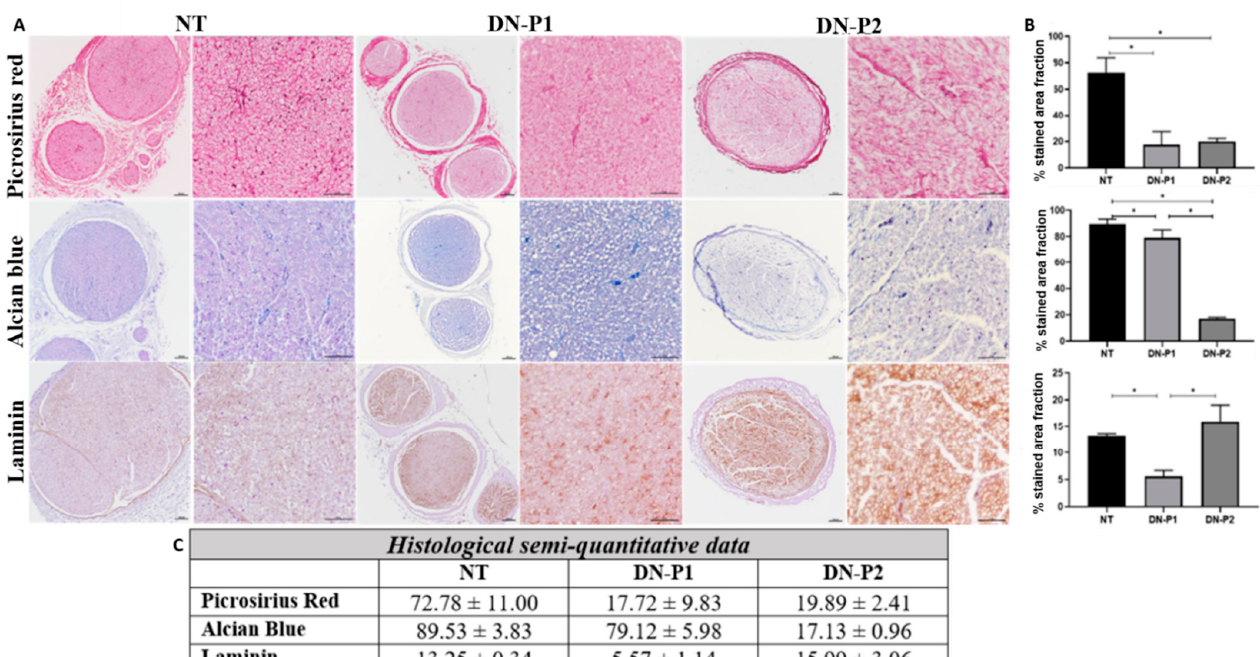
Figure 3. Representative histological and immunohistochemical panels and semiquantitative analysis of native and decellularized rat sciatic nerves reporting the ECM components . ( A ) The three main ECM components, i.e., collagen, proteoglycans, and laminin, are stained with Picrosirius red, Alcian blue, and laminin immunostaining, respectively. Scale bar = 100 µm for lower magnification images and 50 µm for higher magnification images. ( B ) Graphs representing semiquantitative analysis of the % occupied by the staining normalized to the whole nerve area. ( C ) Semi-quantitative raw data. * indicate statistically significant differences ( p < 0.05).